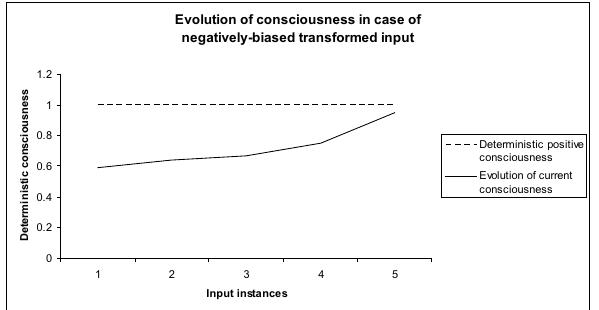
Fig. 28. Evolution of consciousness in system with transformed excitation ( (cid:16) biased C2).